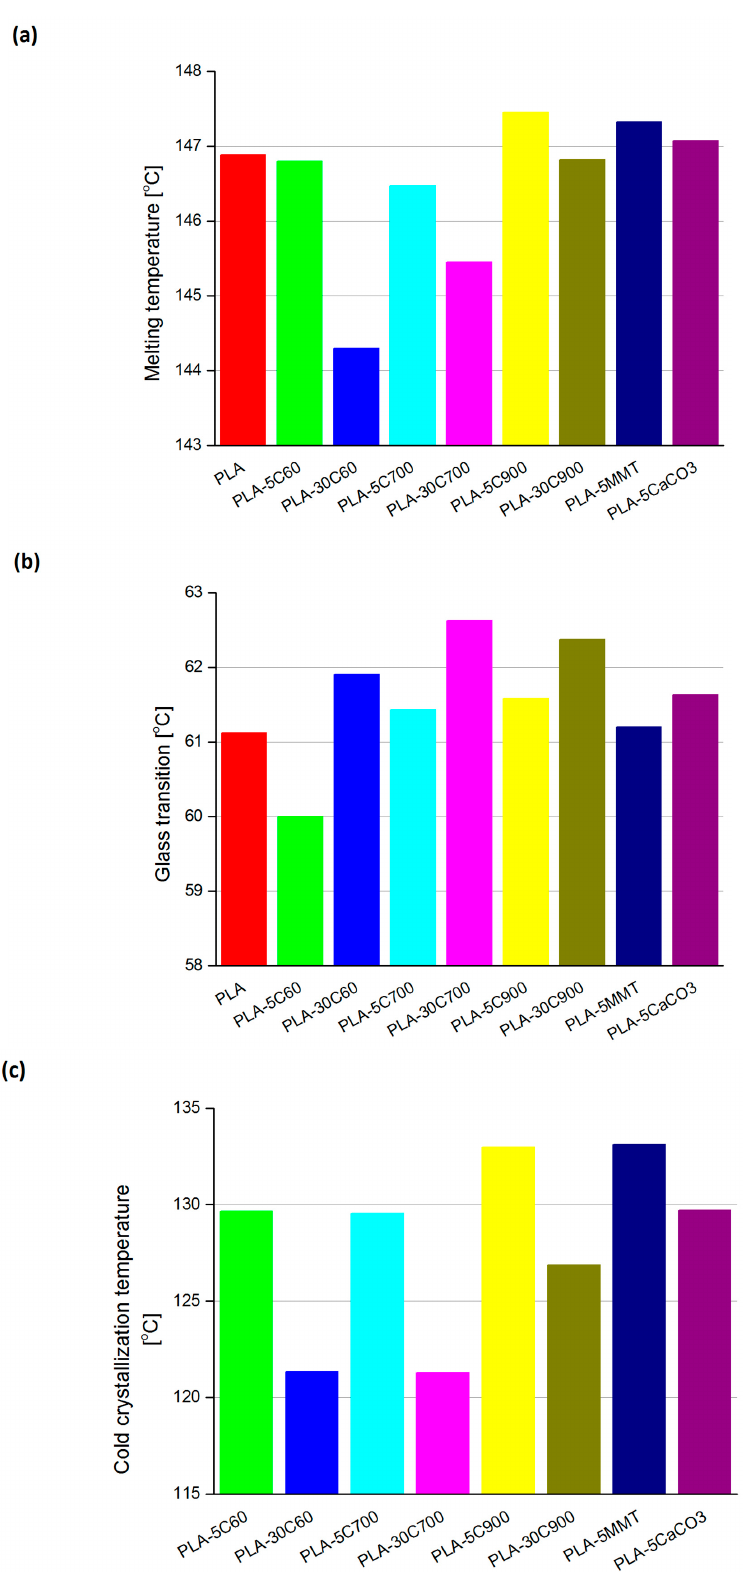
Figure 3. Melting temperatures ( a ) glass transition ( b ) and cold crystallization ( c ) for all of the investigated composites. Cold crystallization temperature was not recorded for PLA sample.